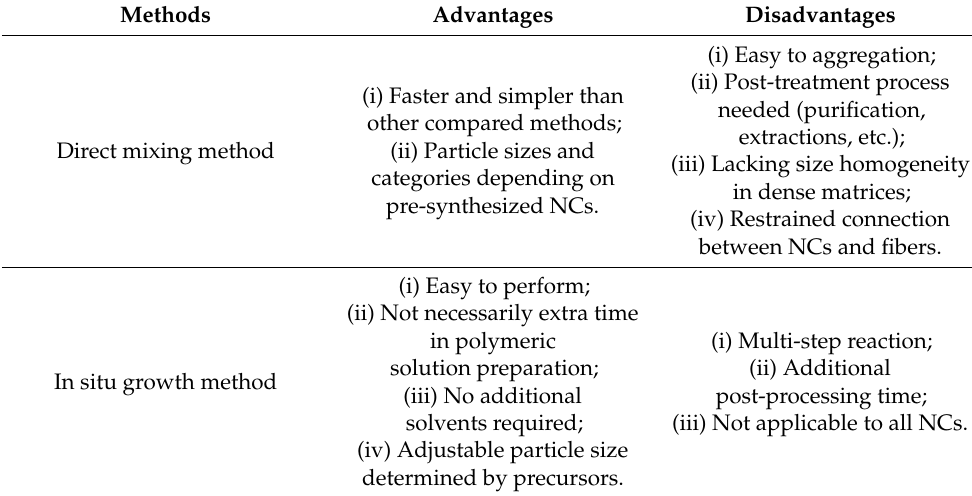
Table 1. Advantages and disadvantages of direct mixing method and in situ growth